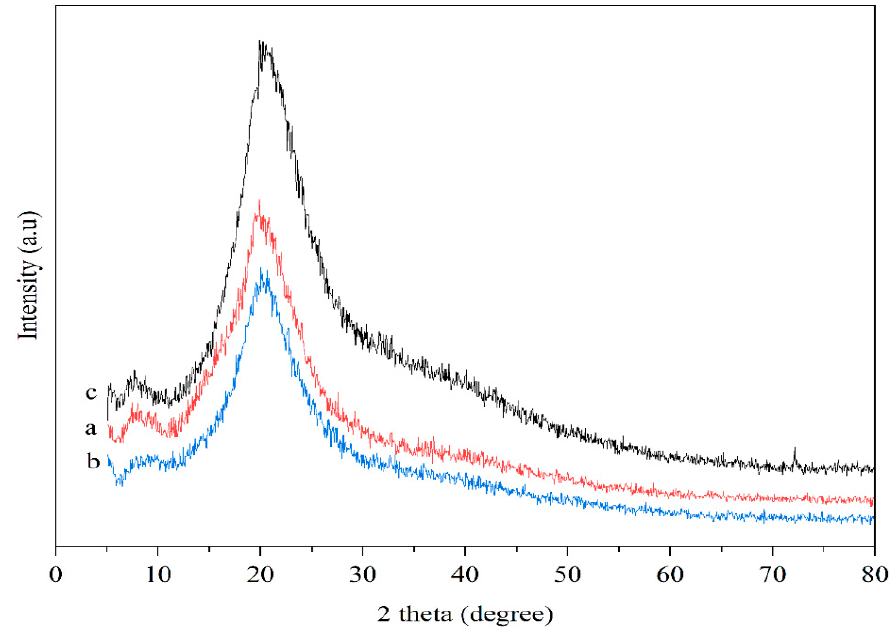
Figure 3. X-ray di ff ractograms of G/ChNF ( a ), G/ChNF/BA ( b ), and G/ChNF/SPA ( c ) smart indica-